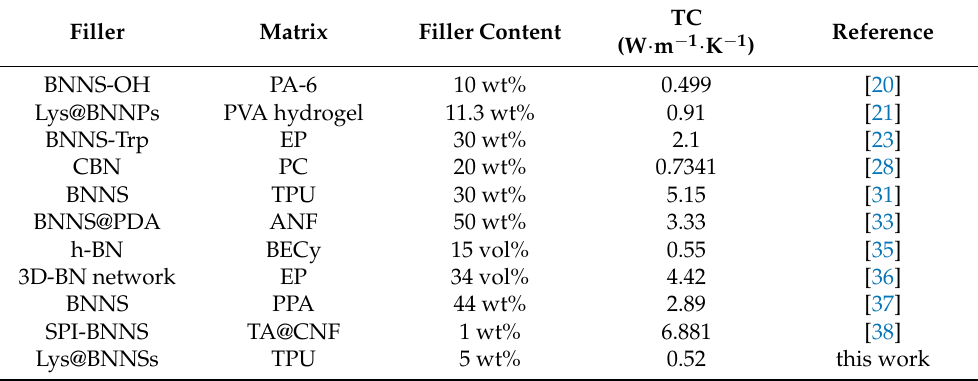
Table 1. TC of our Lys@BNNS/TPU composites in this study and BN/polymer composites which were previously